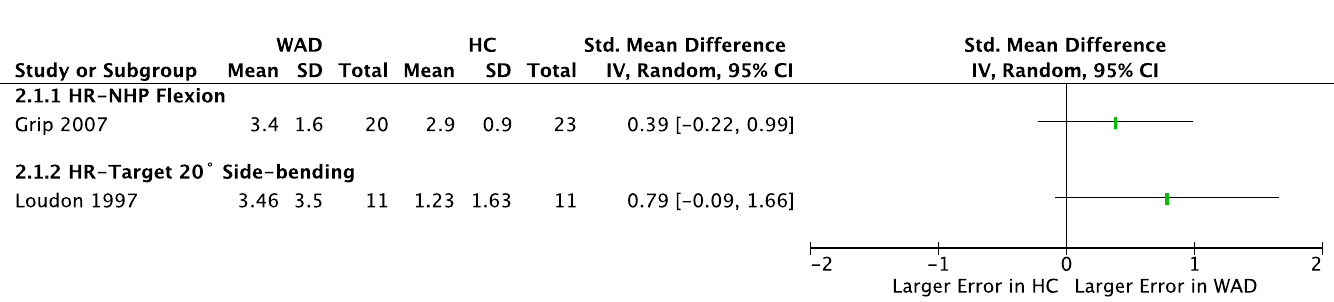
PLOS ONE | https://doi.org/10.1371/journal.pone.0249659 April 8,